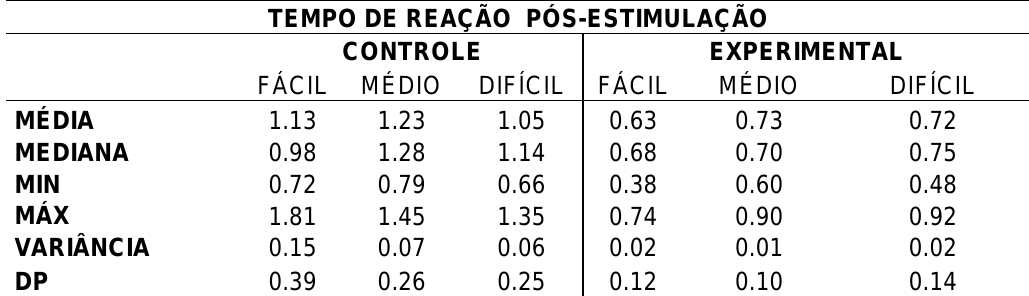
Tabela 3. Valores da estatística descritiva do tempo de reação. A tabela representa os valores de